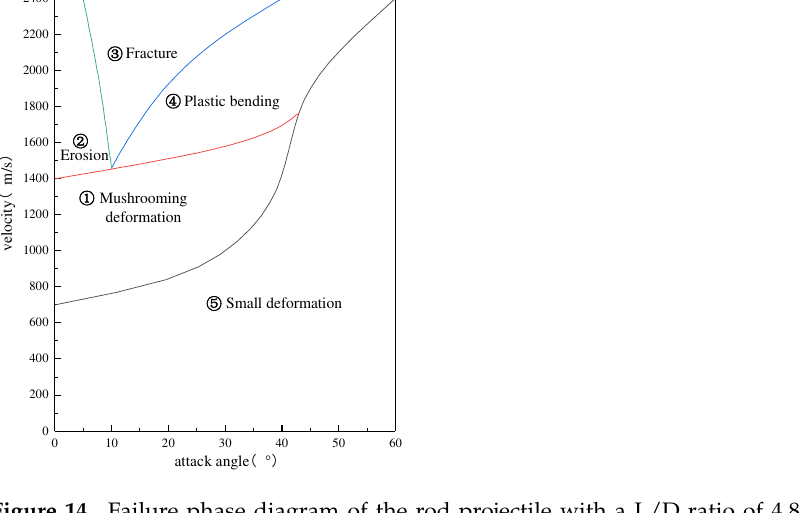
Figure 14. Failure phase diagram of the rod projectile with a L/D ratio of 4.8 penetrating into liquid cabin. ① Mushrooming ② Erosion (Condition 6) ③ Fracture (Condition 7) ④ Plastic bending (Condition 2).